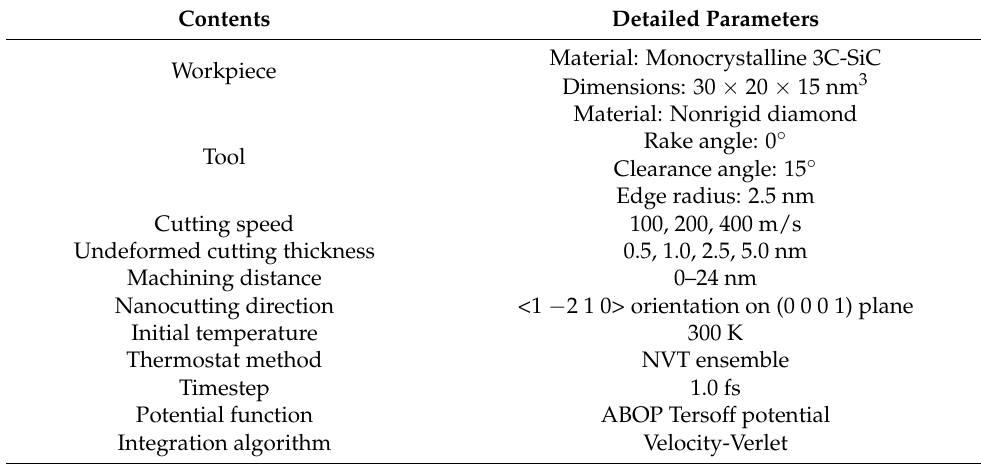
Figure 1. MD model of nanometric cutting on monocrystalline 3C-SiC. Table 1. Detailed nanometric cutting parameters in the MD simulations.